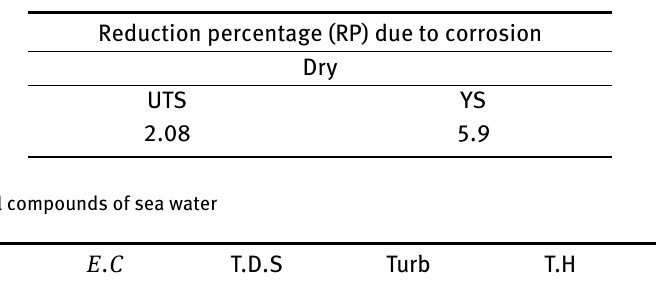
Table 3: Reduction percentage (RP) due to corrosion